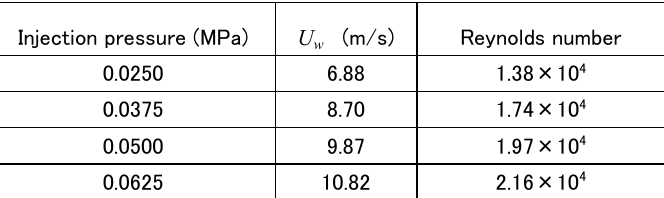
Table 2 The jet velocity and Reynolds number in nozzle A